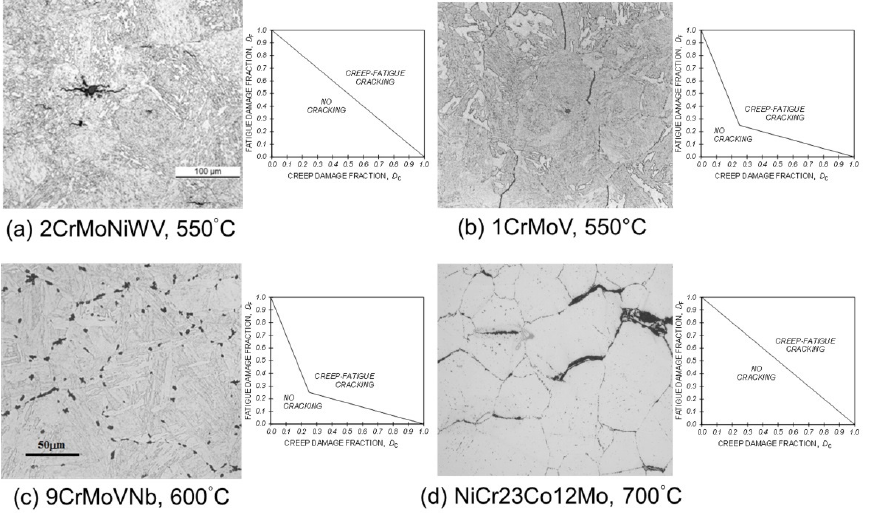
Figure 4. Creep damage development: ( a ) transgranular due to particle ‐ matrix decohesion in creep ductile 2CrMoNiWV steel at 550 °C; ( b ) intergranular in a 1CrMoV steel at 565 °C; ( c ) intergranular in a 9CrMoVNb steel at 600 °C; ( d ) intergranular in a NiCr23Co12Mo alloy at 700 °C.